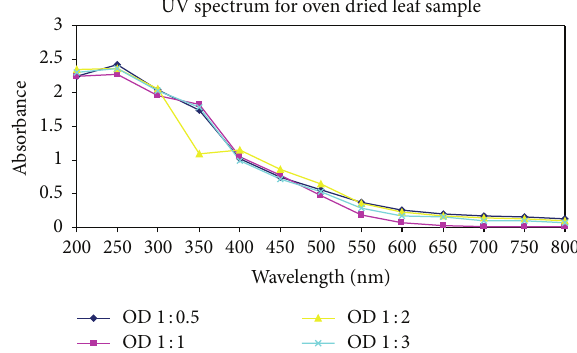
Figure 2: UV-Vis absorption spectra recorded as a function of time of reaction of four different solutions of silver ions by Pimenta dioica oven-dried leaves extract in ratios of 1:0.5, 1: 1, 1:2, and 1: 3 after 10 minutes reaction kinetics.